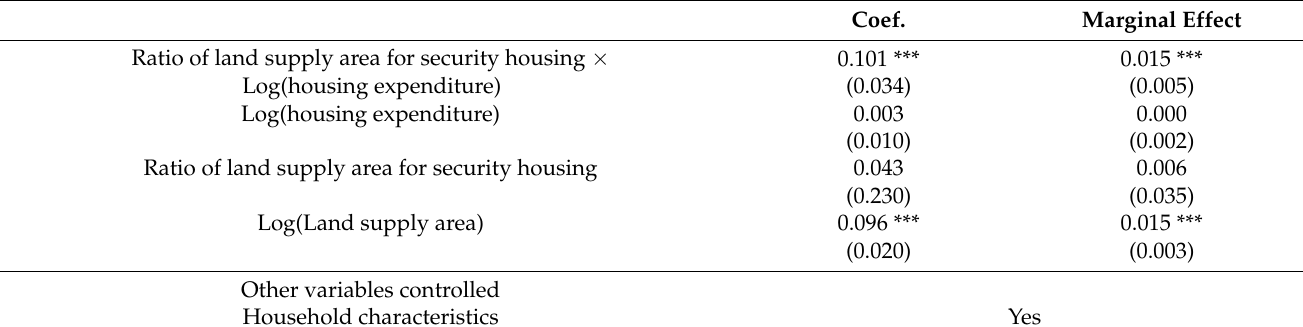
Table 8. Estimated results of housing security, housing expenditure and settlement intentions.